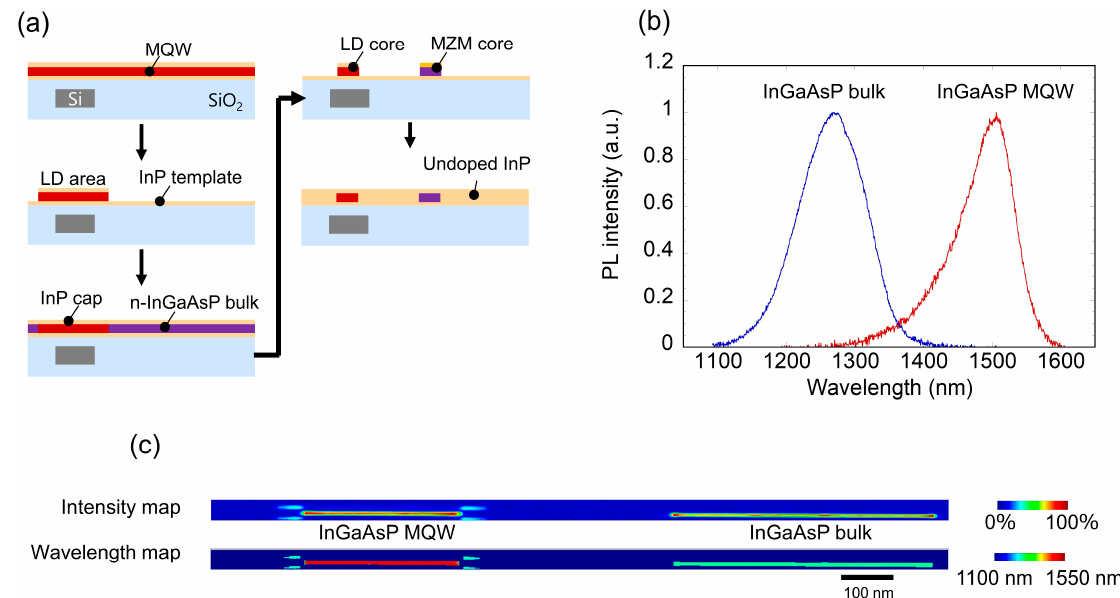
Figure 15. ( a ) Process flow of integrating different ‐ bandgap BHs using epitaxial regrowth; ( b ) normalized PL spectra for directly bonded indium gallium arsenide phosphide (InGaAsP) MQW and epitaxially grown InGaAsP bulk buried with InP; ( c ) PL ‐ intensity and PL ‐ wavelength maps for both BHs.